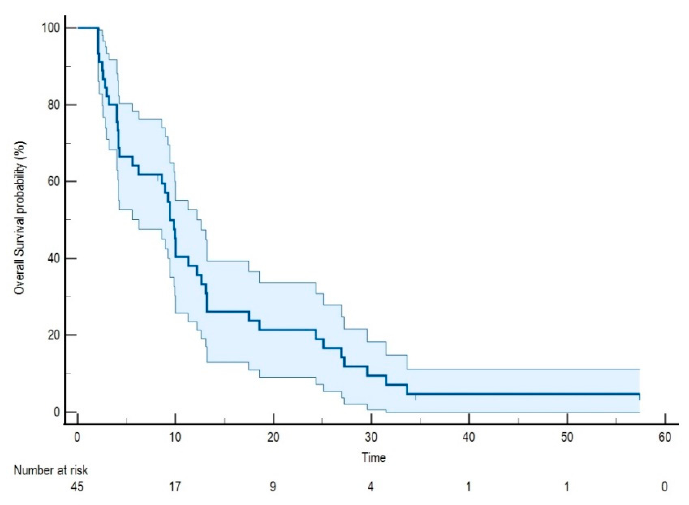
Figure 1. Kaplan Kaplan–Meier survival function of the study cohort.